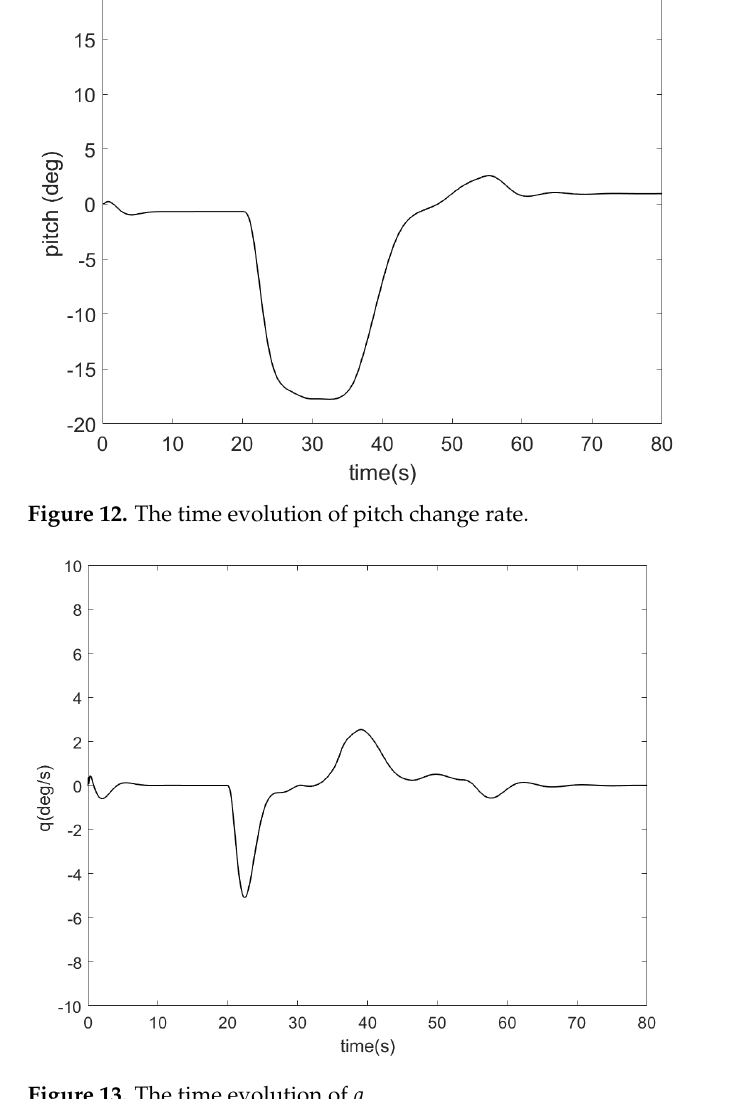
Figure 13. The time evolution of q